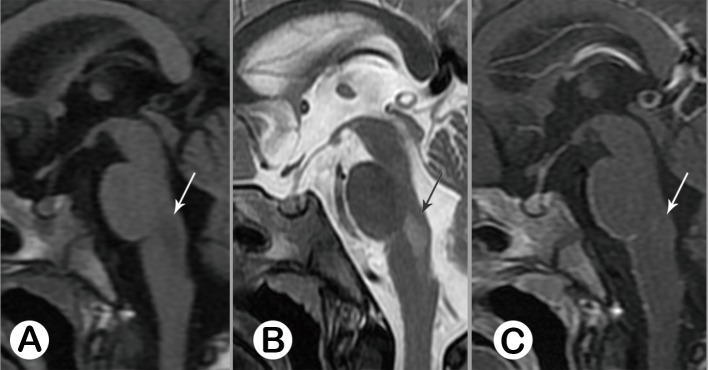
Acute stage typeⅠ.Female, 3 years old, on the 9th day of the disease.Sagittal MR images revealed a longitudinal lesion at the posterior junction region of the pons and medulla oblongata, with prolonged T1 (A, white arrow) and prolonged T2 (B, black arrow) signal, without enhancement (C, white arrow). See follow-up study in Fig 9.